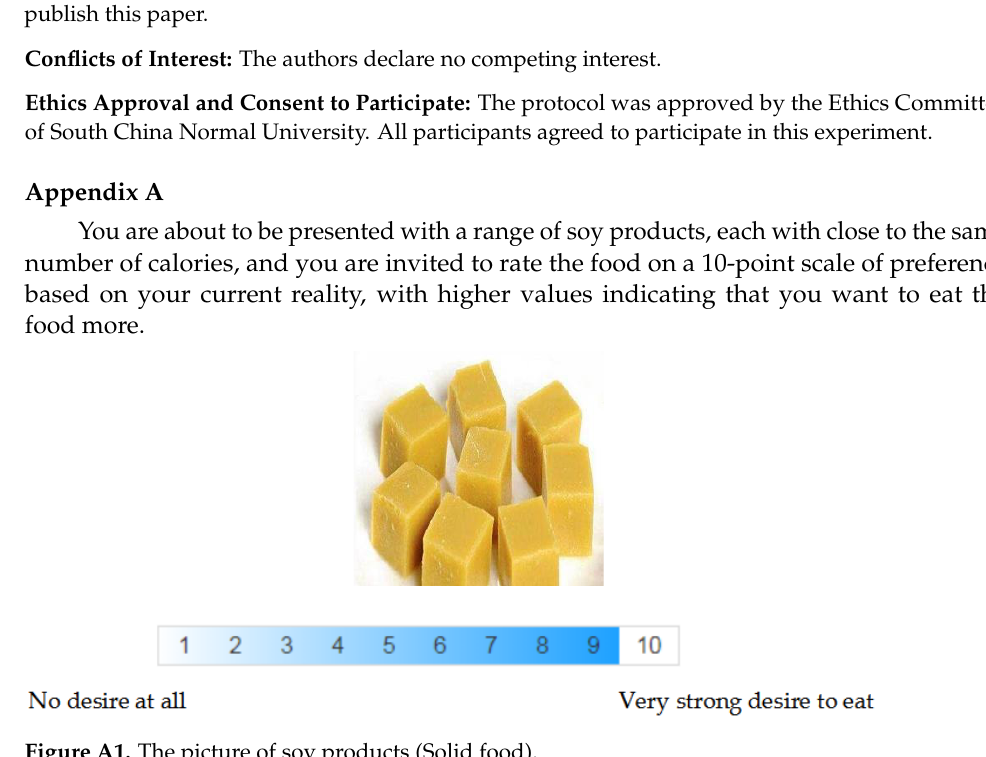
Figure A1. The picture of soy products (Solid food).